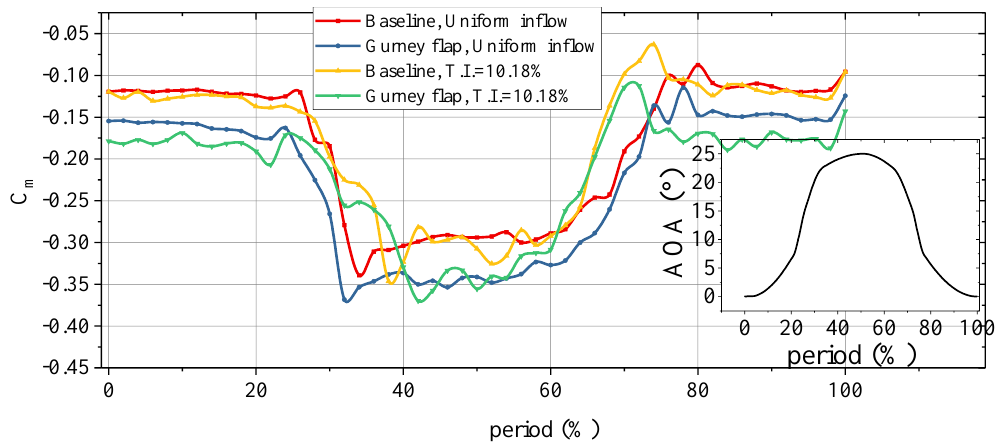
Figure 10. Comparison of the C m in a pitching cycle (A = 12.5, α mean = 12.5 and K = 0.0167).